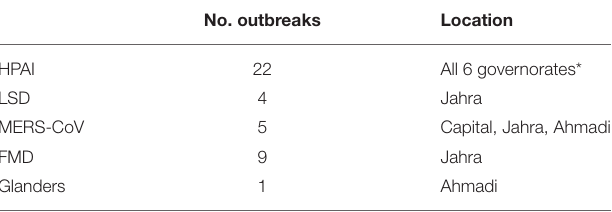
TABLE 1 | Animal disease outbreaks and locations in Kuwait